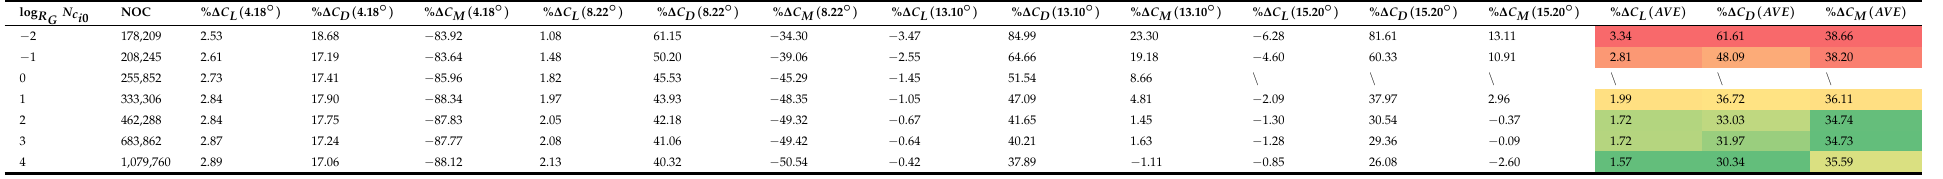
Table 9. Comparison of results of H-mesh based on various chord-wise spacings with that of experimental benchmark data adopted from [25] in relative differences with 386 nodes in chord-wise direction for reference